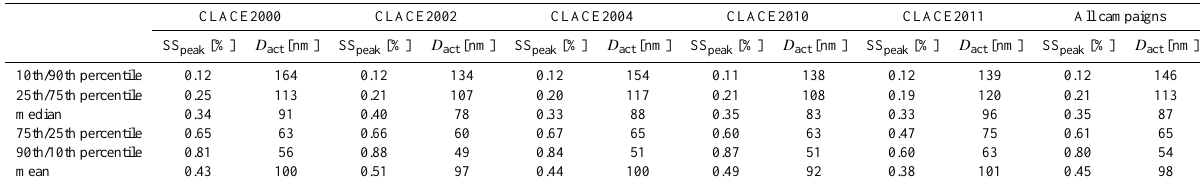
Table 2. Statistical values of the effective peak supersaturation (SS peak ) and activation diameter ( D act ) during all CLACE summer cam- paigns (for CLACE2000 only NW wind conditions). Simultaneous CCN data used for CLACE2011 and CCN climatology data used for CLACE2000, 2002, 2004 and